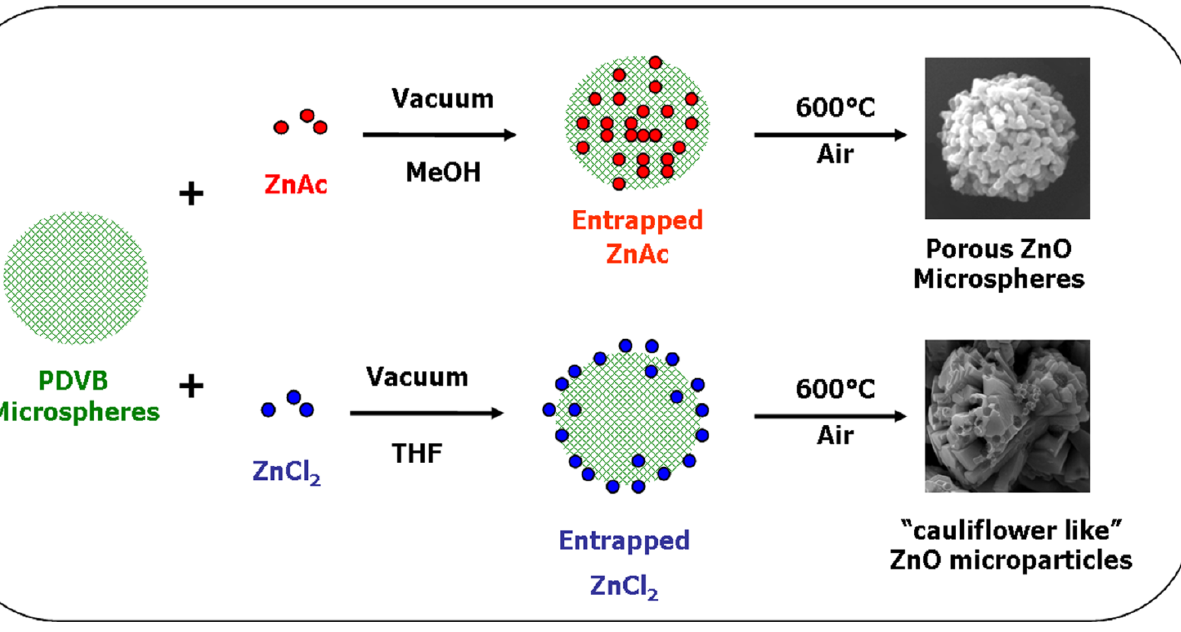
Figure 11. Schematic illustration of the preparation mechanisms of ZnO microparticles with spherical and with “cauliflower-like” shapes from zinc acetate and ZnCl